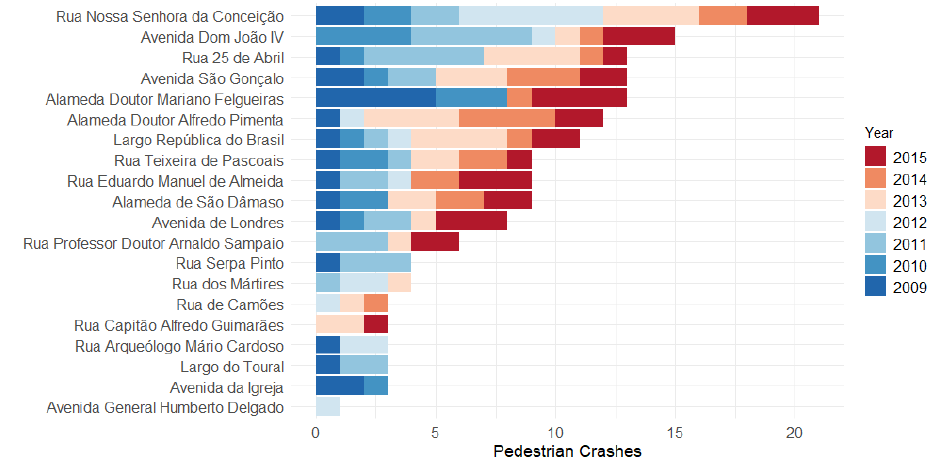
Figure 4. The number of pedestrian crashes per road and year in Guimarães.